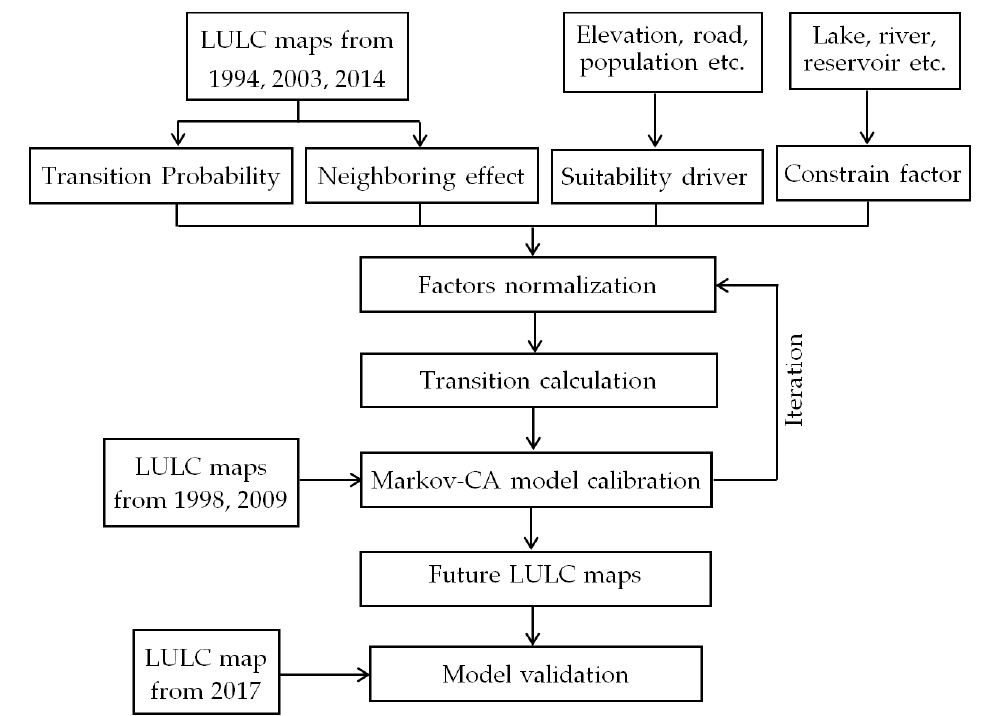
Figure 3. Flowchart of the Markov-CA model.